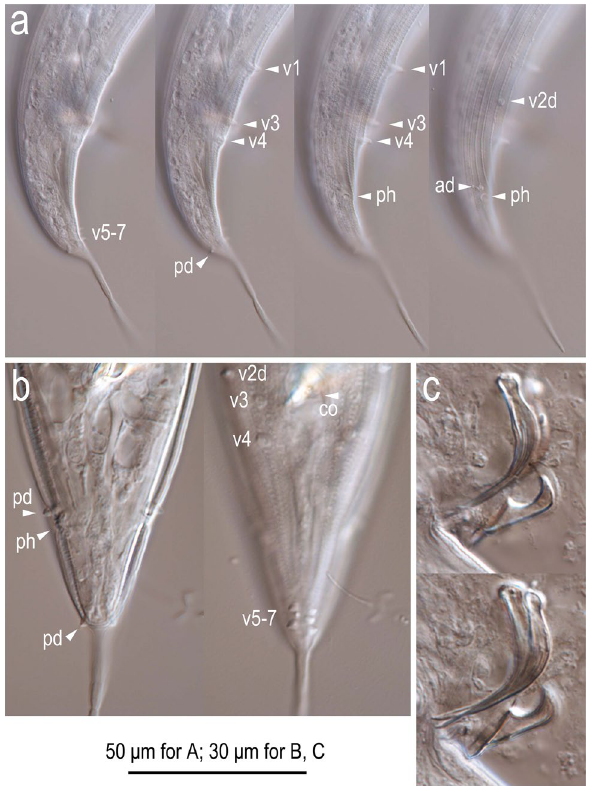
Figure 7. Light micrographs of male tail characters of Onthodiplogaster japonica n. gen., n. sp. ( a ) Right lateral view of entire tail in four different focal planes; ( b ) posterior region in two different focal planes; ( c ) flattened spicule and gubernaculum in two different focal planes. Labels are as follows: ph = phasmid; v + number, ad, pd = genital papillae according to the terminology by Sudhaus & Fürst von Lieven 1 .